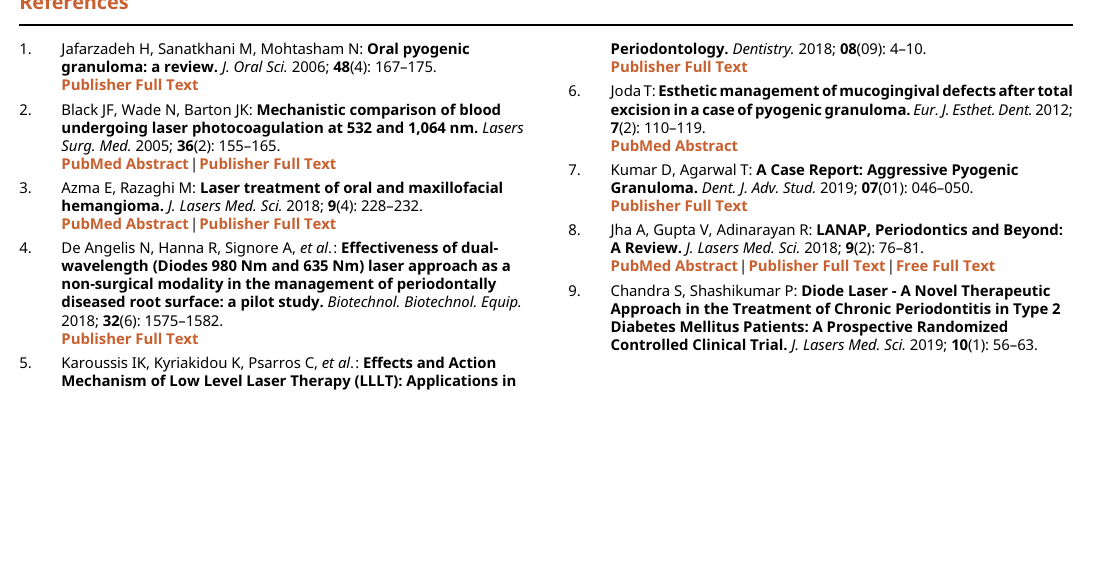
Figshare. CARE flowchart. DOI: